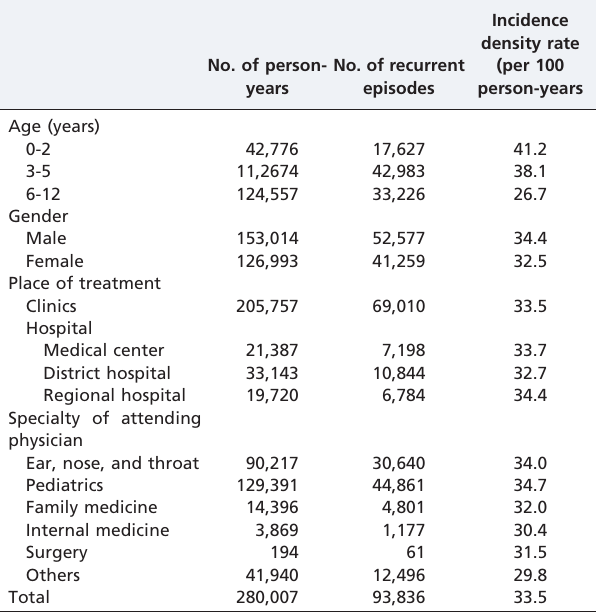
Table 2 - Incidence density rate of recurrence of acute otitis media within a one-year period following the baseline attack in 2006 (N= 283,084).